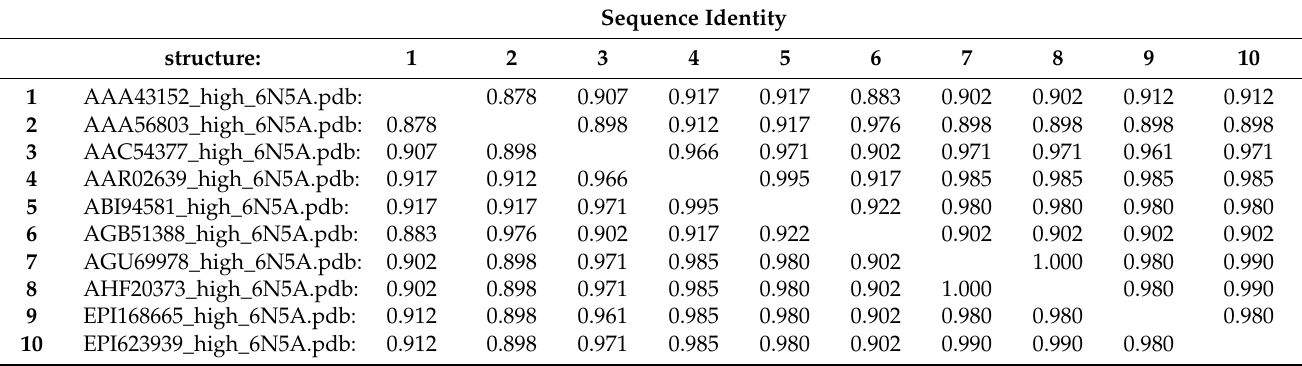
Table 2. Sequence identity, RMSD and Q-score for HPAI sequences modelled on PDB 6N5A. Sequence